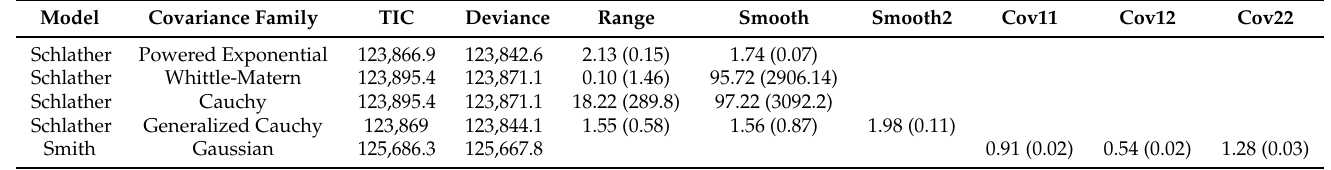
Table 4. Max-stable process fitted to the second cluster of the average annual